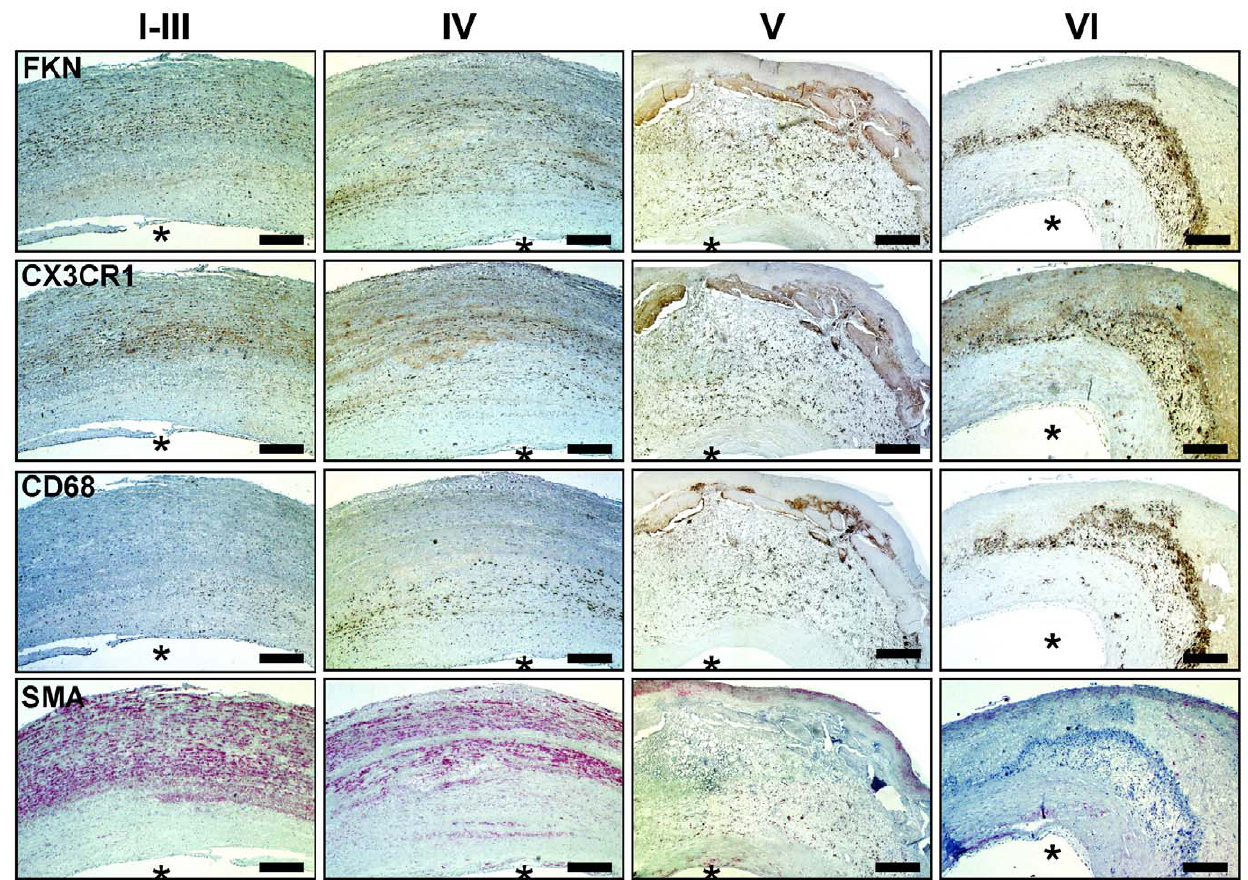
Figure 1. Immunohistochemistry of FKN and CX3CR1 in atherosclerotic lesions of human carotid arteries. Representative images of human atherosclerotic plaque in different stages of lesion development (I–VI). Staining was performed with antibodies against FKN, CX3CR1, the macrophage marker CD68, and a -smooth muscle actin (SMA). Bars, 200 m m. Asterisks indicate the luminal side of the vessel.